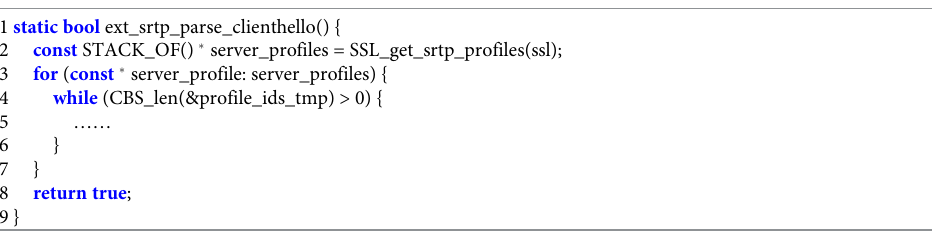
Table 7. Code for parsing negotiates